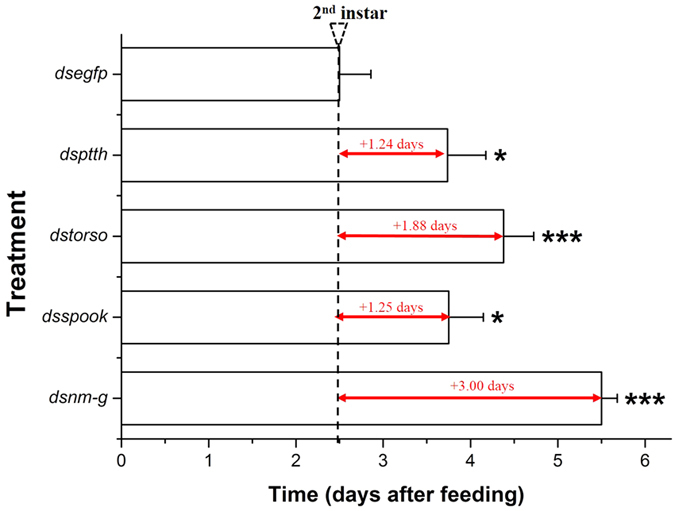
The different developmental period among RNAi-treated groups.Larvae fed with dsegfp were used as negative control. Asterisk shows significant difference (*p < 0.05, **p < 0.01 and ***p < 0.001, Student’s t-test).